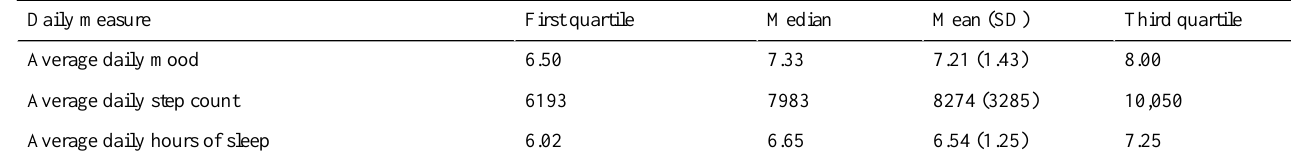
Table 2. Summary statistics of daily mood, activity, and sleep during the study, averaged over each week of the study. These are the primary outcomes and moderators used in the analyses of all study aims.